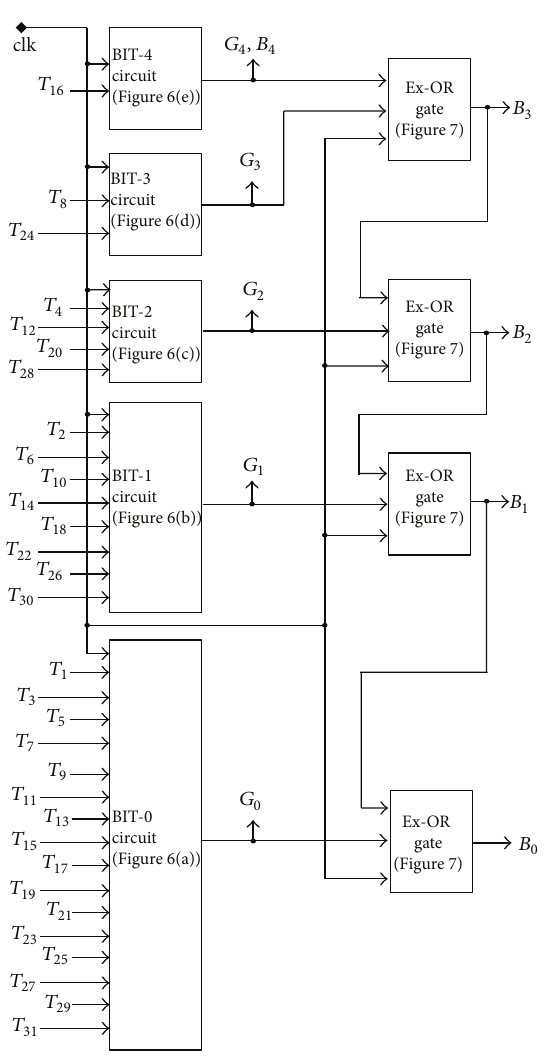
Figure 8: Complete schematic diagram of